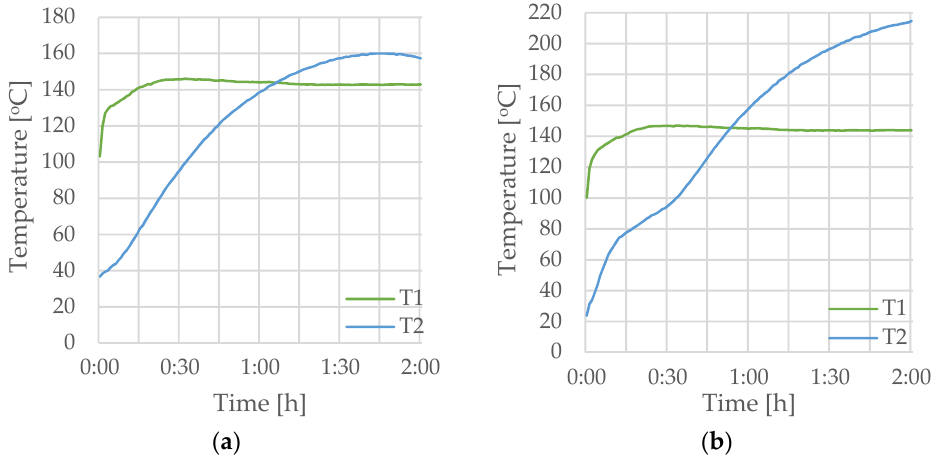
Figure 6. The temperature of sludge dust in a 98.17 cm 3 basket: ( a ) at a furnace temperature of 142 °C with no evidence of dust ignition, ( b ) at a furnace temperature of 144 °C with a dust ignition. The temperature of sludge pellets in different sample baskets and the furnace tem- perature are presented in Figures 7–9.